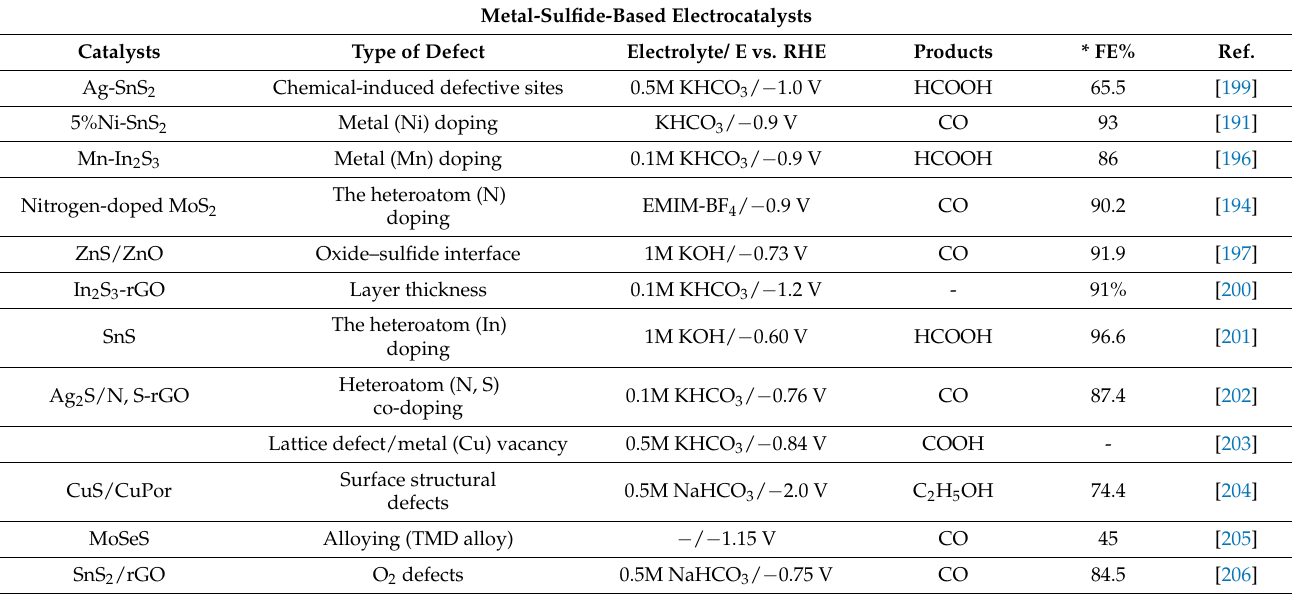
Table 4. Metal-sulfide-based electrocatalysts for electrochemical CO 2 -RR. Metal-Sulfide-Based